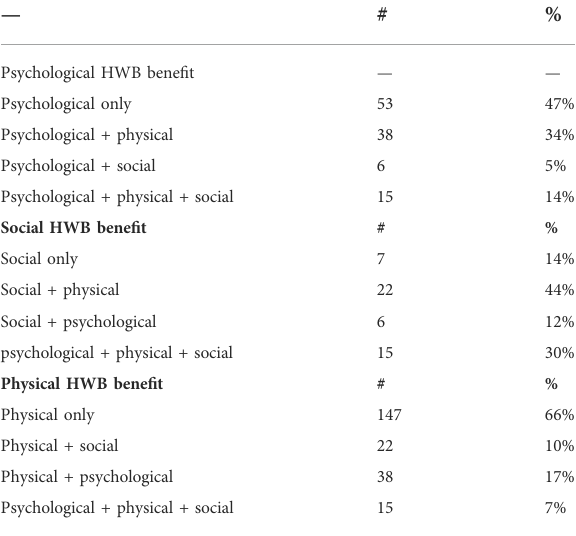
TABLE 4 Human wellbeing affordances. Individual psychological UGS affordances (n = 112) provided by respondents. Individual social